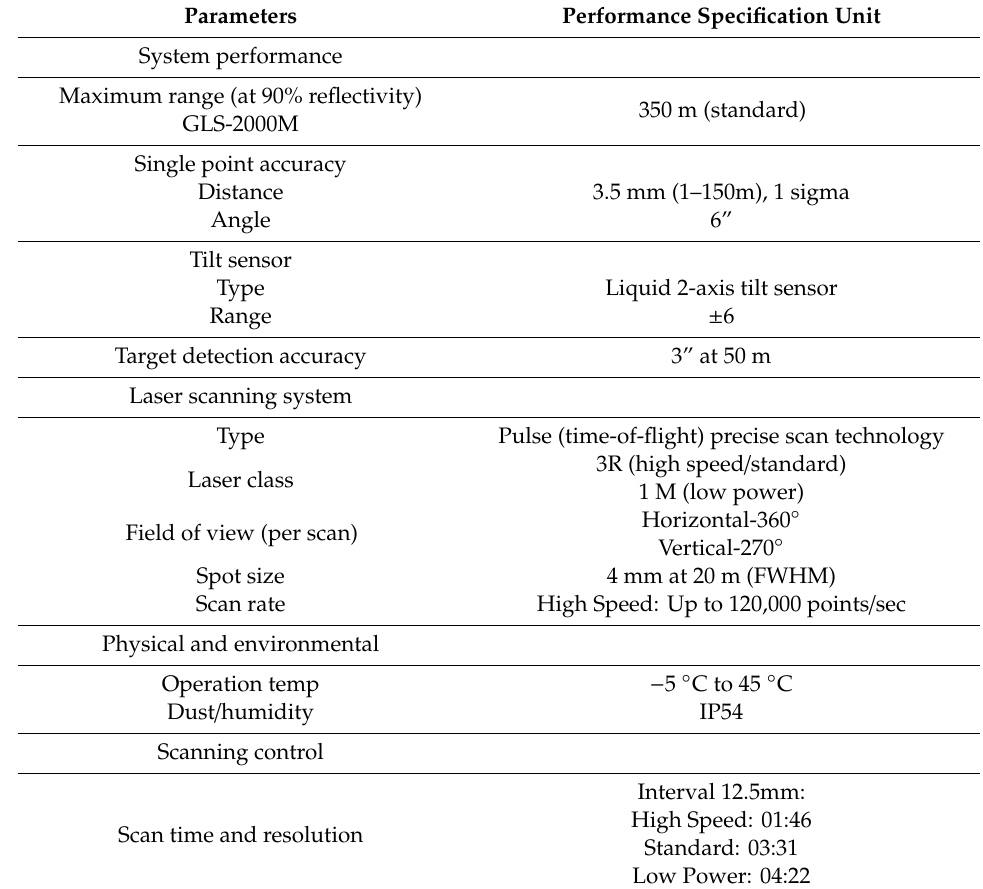
Table 1. Detailed specifications of 3D scanner